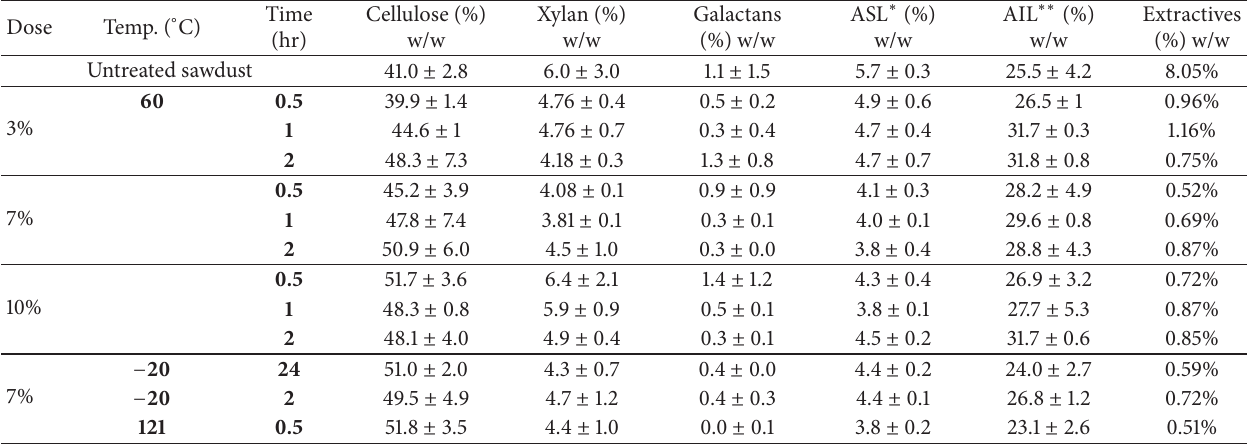
Table 1: Composition of sawdust before and after pretreatment with